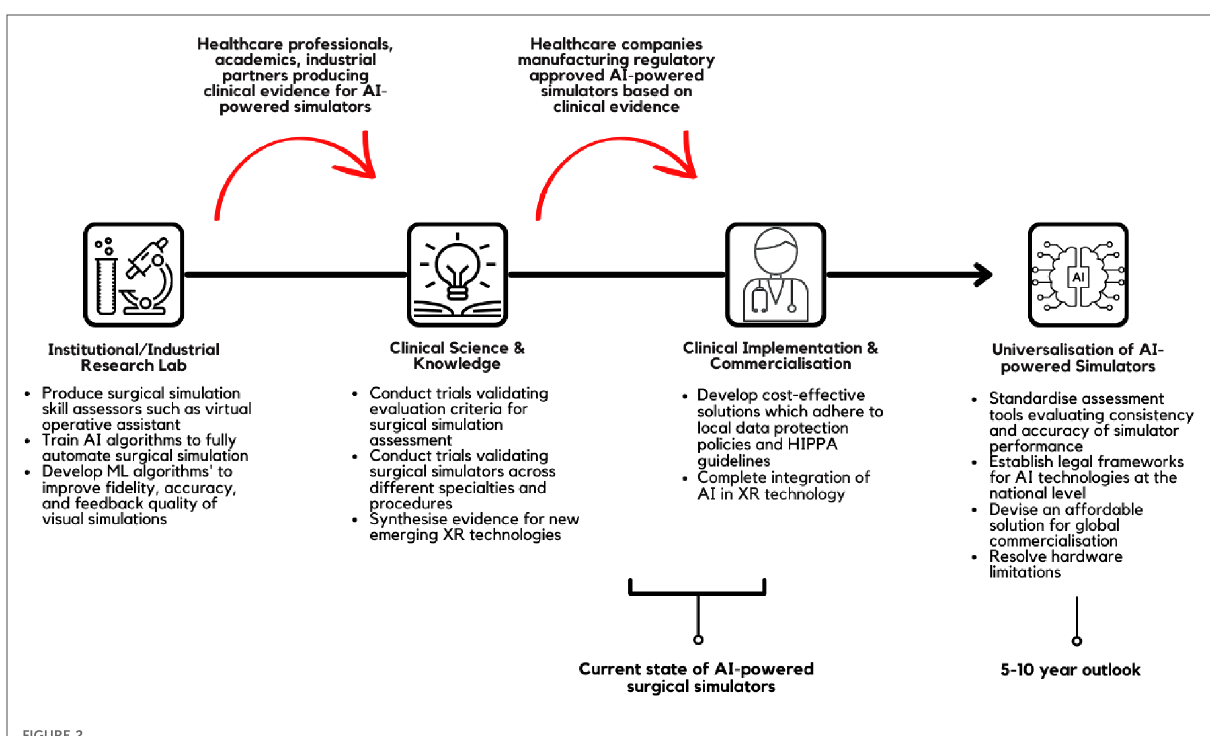
FIGURE 2 Recommendation and suggestions for AI-powered surgical